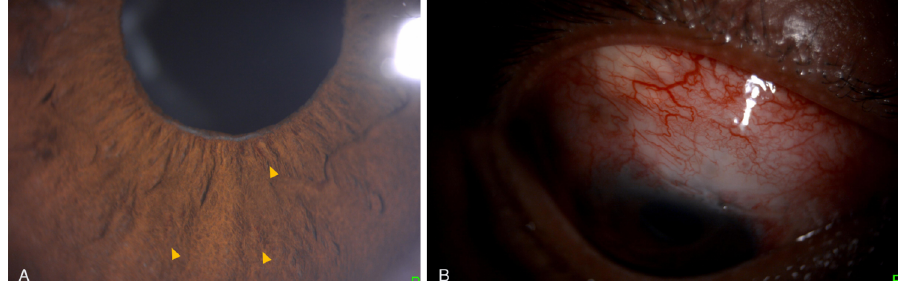
Figure 2: Slit lamp photographs showing (A) fine rubeosis affecting the pupil edge and iris (yellow arrowheads) and (B) low rise and increased vascularity on the filtering